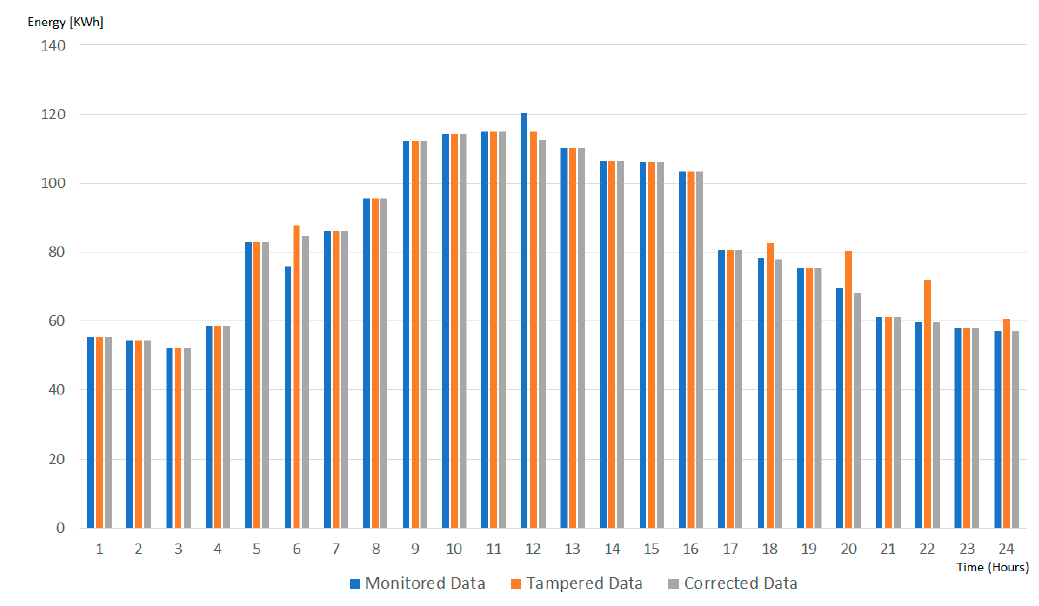
Figure 13. Energy transactions stored on-chain on hourly basis.